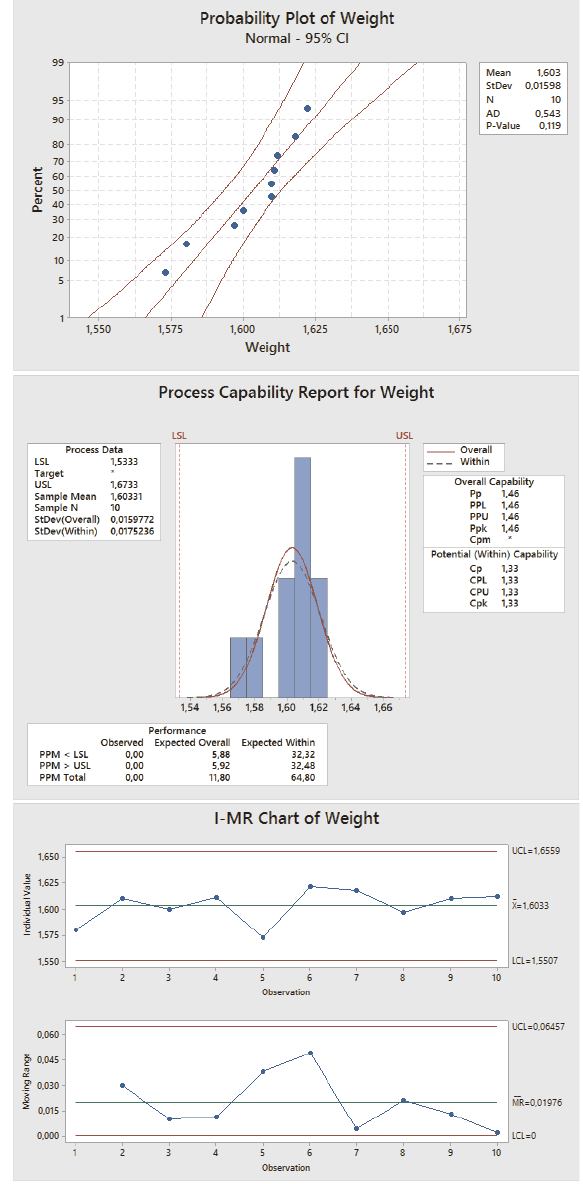
Figure 22: Probability Plot, Process Capability Report and I-MR Chart for the weight of